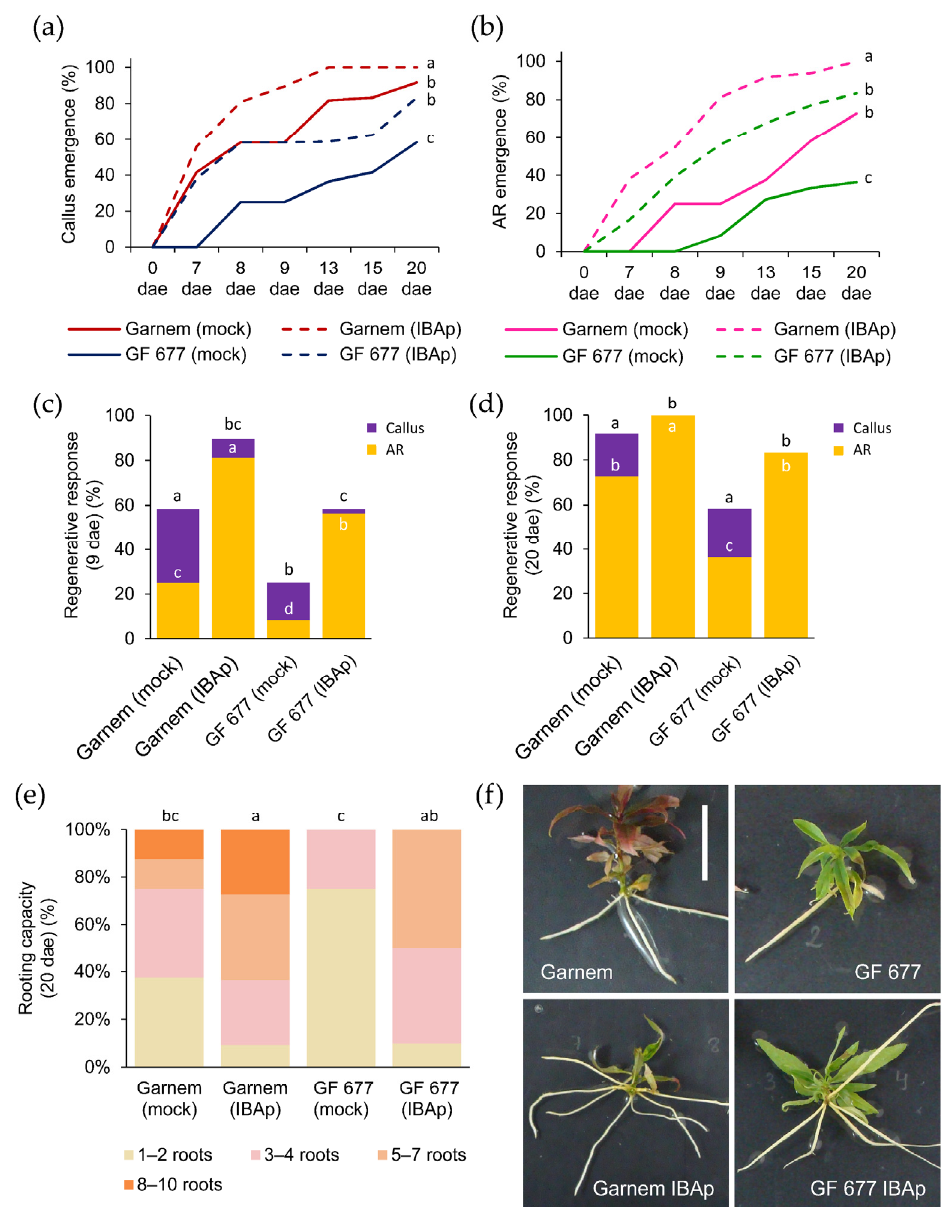
Figure 4. Rooting performance of Garnem and GF 677 microcuttings after a 24 h pulse of IBA. ( a , b ) Appearance of ( a ) callus and ( b ) ARs over time in microcuttings treated with and without a 24 h pulse of IBA 0.9 mg/L (IBAp). Letters indicate significant differences ( p -value < 0.05) between categories. ( c , d ) Regenerative response estimated by the percentage of cuttings with callus and ARs at ( c ) 9 days after excision (dae) and ( d ) 20 dae. The number of samples varies from 11 to 48. Letters indicate significant differences ( p -value < 0.05; Chi-square) between genotypes in callus regenerative response, and white letters indicate significant differences ( p -value < 0.05; Chi-square) between genotypes in AR regenerative response. ( e ) Rooting capacity measured at 20 dae. Letters indicate significant differences ( p -value < 0.01) for the average number of ARs. The number of samples in the rooting capacity graph varies from 11 to 12. ( f ) Representative images of Garnem and GF 677 microcuttings at the end of the experiment. Scale bar: 2.5 cm.